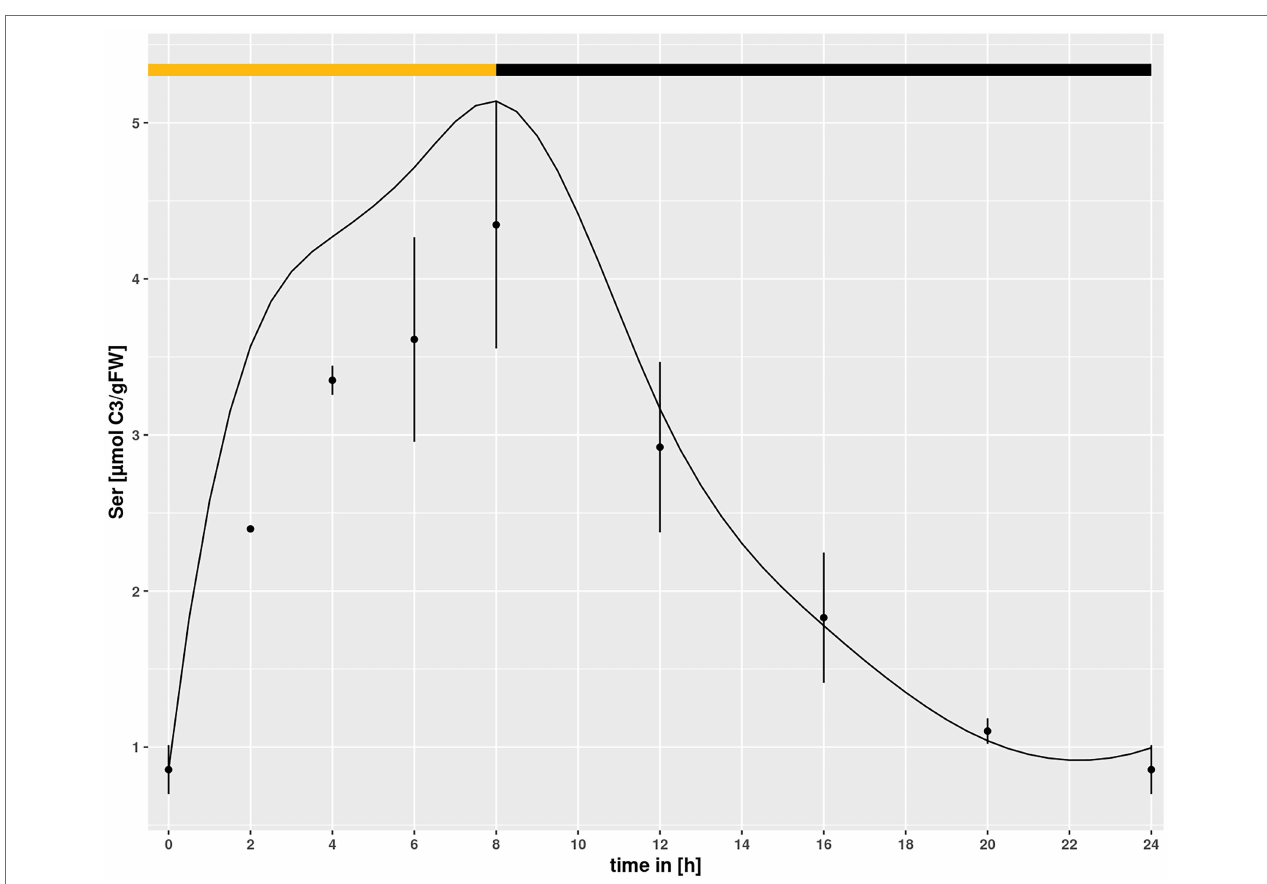
FIGURE 5 | Diurnal course of serine for hpr1-1 at eCO 2 concentrations. Dots represent means with standard error ( n = 5). Lines represent the mean of 20 simulations using the minimum of the km value of the simulations of Col-0 ambient CO 2 as lower boundary. The light phase is indicated by a yellow bar and dark phase indicated by black